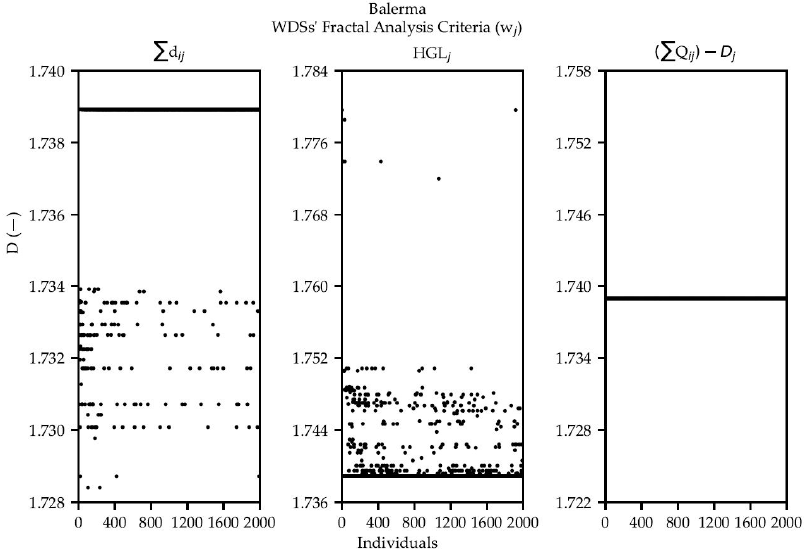
Figure 8. WDSs’ fractal analysis criteria ( w j ) applied to a retrofitted OPUS/NSGA-II Balerma